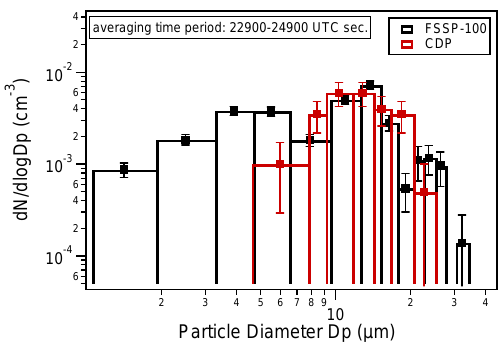
Figure 7. PSC particle size distributions of the FSSP-100 and CDP measured on the flight of 25 January 2010. Due to instrumental problems only in this one flight of the RECONCILE campaign, the particles detection of the CDP worked well, with a higher-than- usual detection size limit of about 5–8µm. At the same time, the largest PSC particles in relatively high numbers were present in this flight. Note, however, that the FSSP size bins above 30µm contain only three